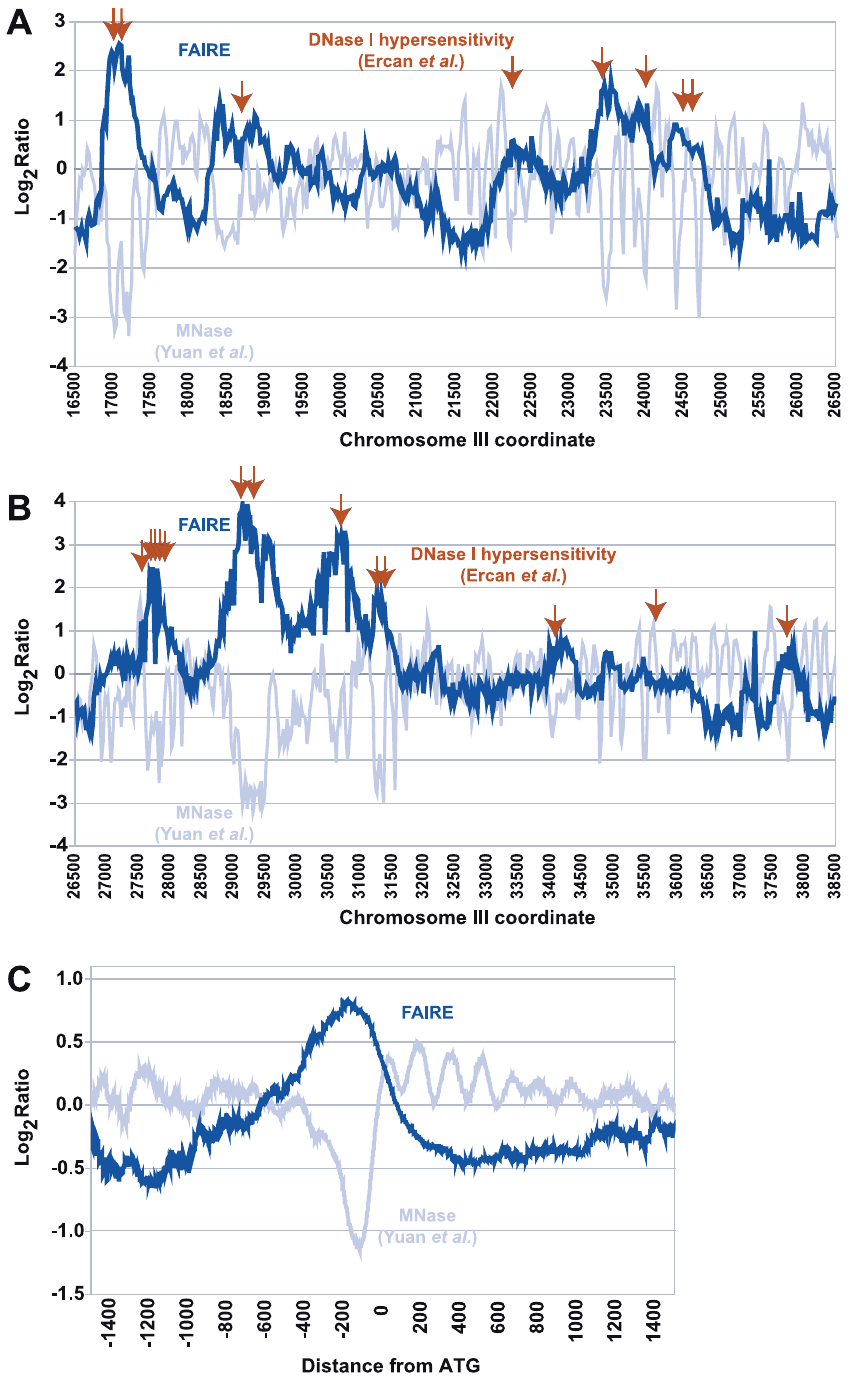
Figure 2. Peaks of FAIRE Enrichment Are Coincident with DNase I Hypersensitive Sites and NFRs (A) Raw data obtained through FAIRE (dark blue) and MNase treatment (light blue) [23] obtained from high-resolution tiling arrays are shown for a 10- kb region of Chromosome III (16500–26500). Red arrows represent previously mapped DNase I hypersensitivity sites [25]. (B) Same as (A), but for a 12-kb region on Chromosome III (26500–38500). (C) Data from tiling arrays were aligned by distance from start codon and averaged over 50-bp windows (step size ¼ 1). DOI: